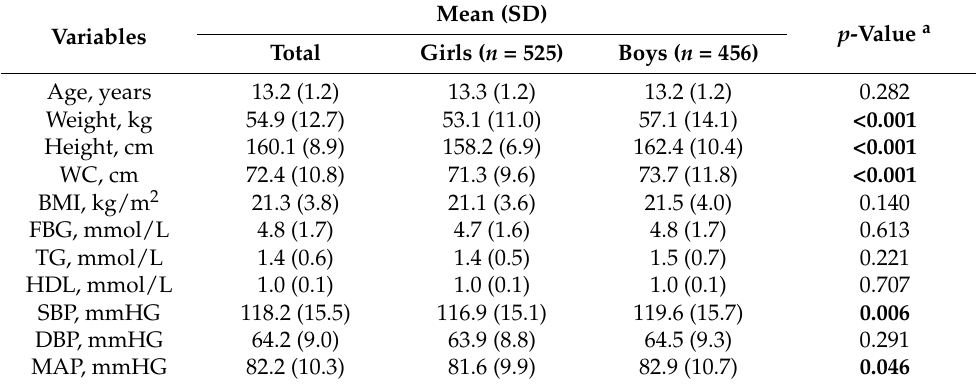
Table 1. Characteristics of participants by age and